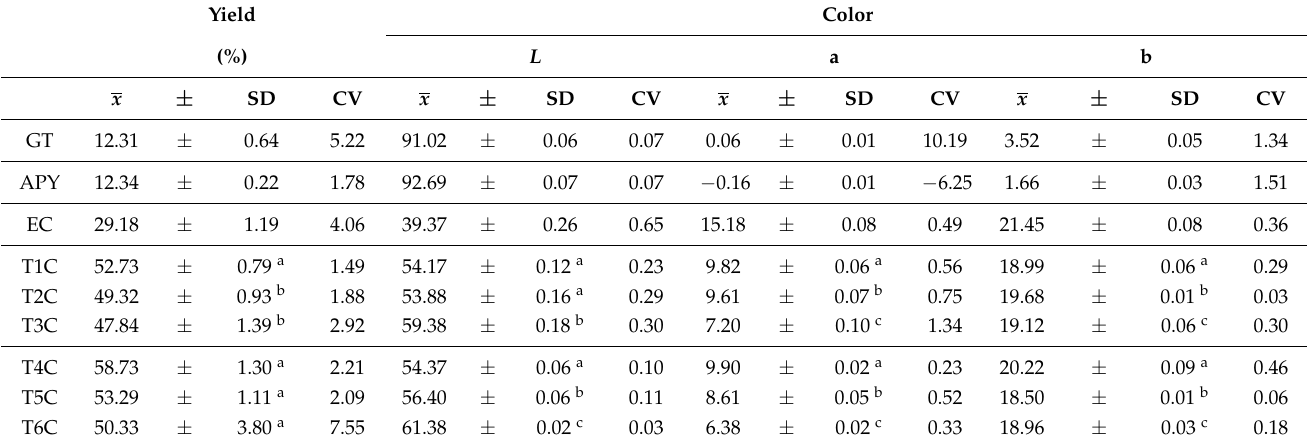
Table 4. Yield and color of tara gum, native potato starch, erythrocytes and